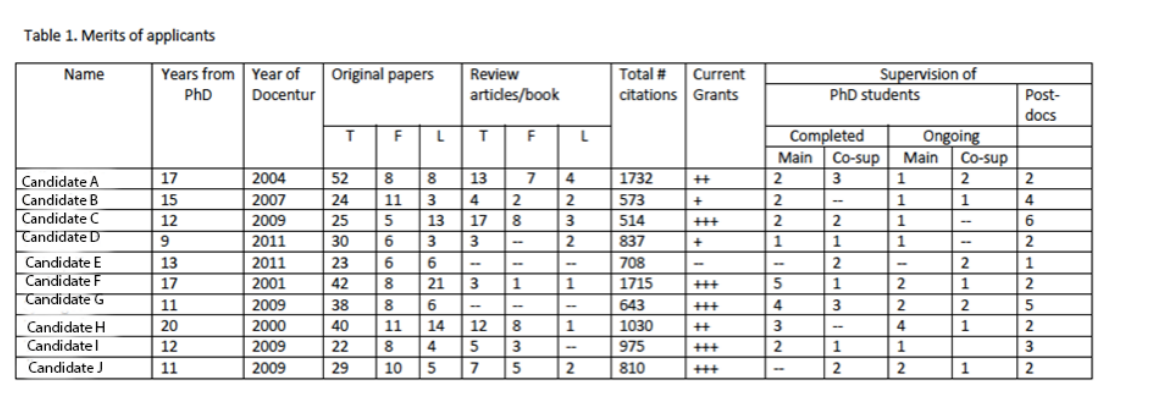
Figure 2 Picture of table titled ‘merits of applicants’ (anonymized) Source: Bio GU 2013: